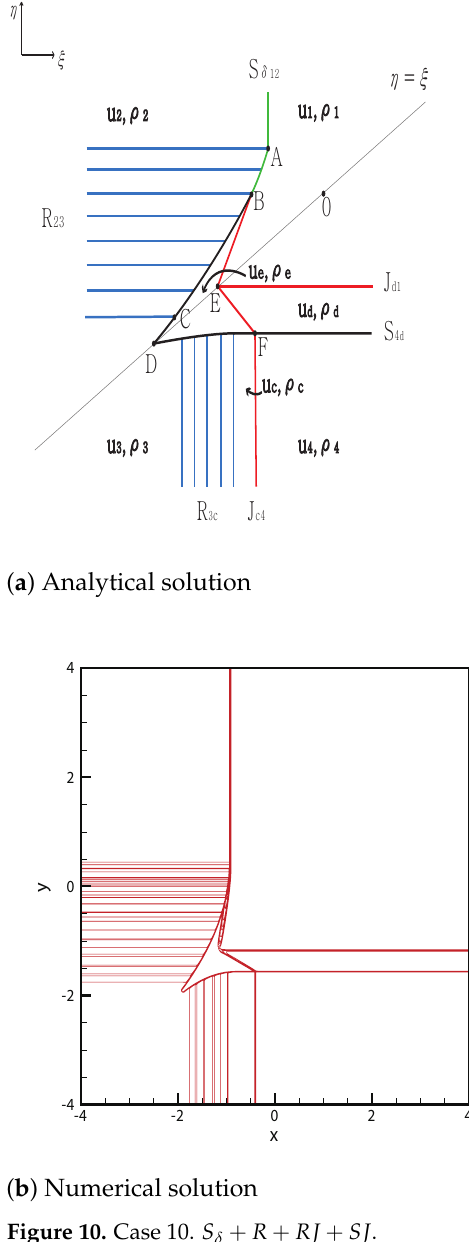
Figure 10. Case 10. S δ + R + RJ + SJ . Case 11. R + S δ + JS + JR ( u 2 < 0 < u 4 < u 3 < u 1